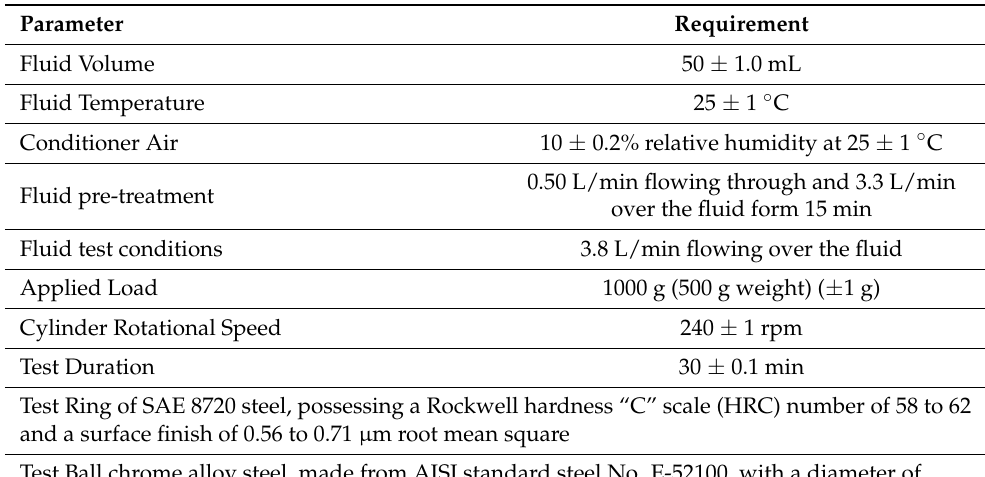
Table 1. Standard test conditions on the BOCLE